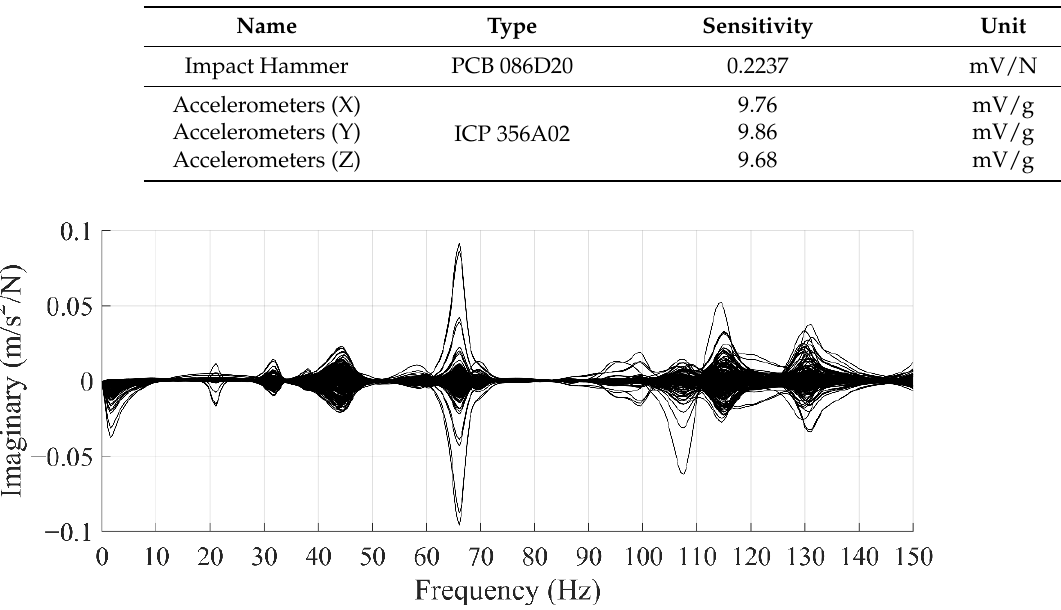
Figure 10. Frequency response function.